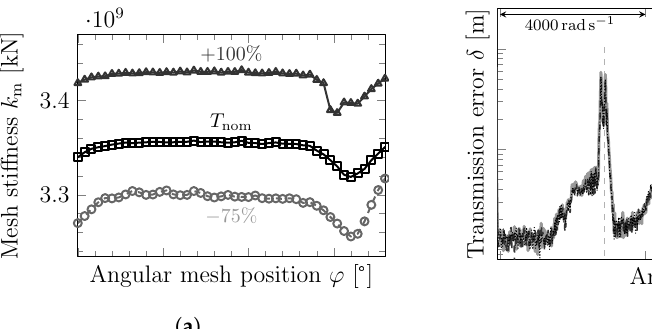
Figure 22. The angle-dependent mesh stiffness k m ( ϕ ) , see subplot ( a ), and the corresponding excitation spectra δ ( ω ) , see subplot ( b ), of the HS stage are calculated for different loads T . The variation of the load level does not significantly influence the frequency spectrum δ ( ω ) of the transmission error. ( a ) Angle-dependent mesh stiffness k m ( ϕ ) for different torques T . ( b ) Excitation spectra resulting from the different k m ( ϕ ) of subplot ( a ). Vertical dashed lines indicate the average meshing frequency ω m,HS and its